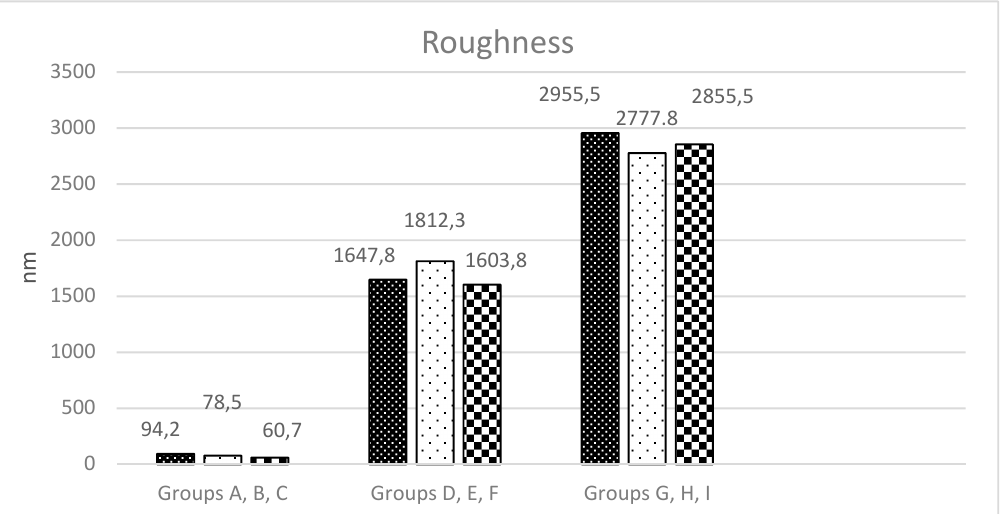
Figure 3. Roughness (Ra) mean values of experimental group.